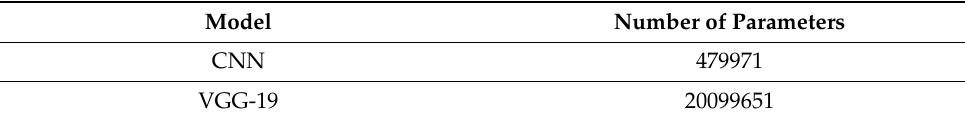
Table 3. Number of parameters in the used classification models .